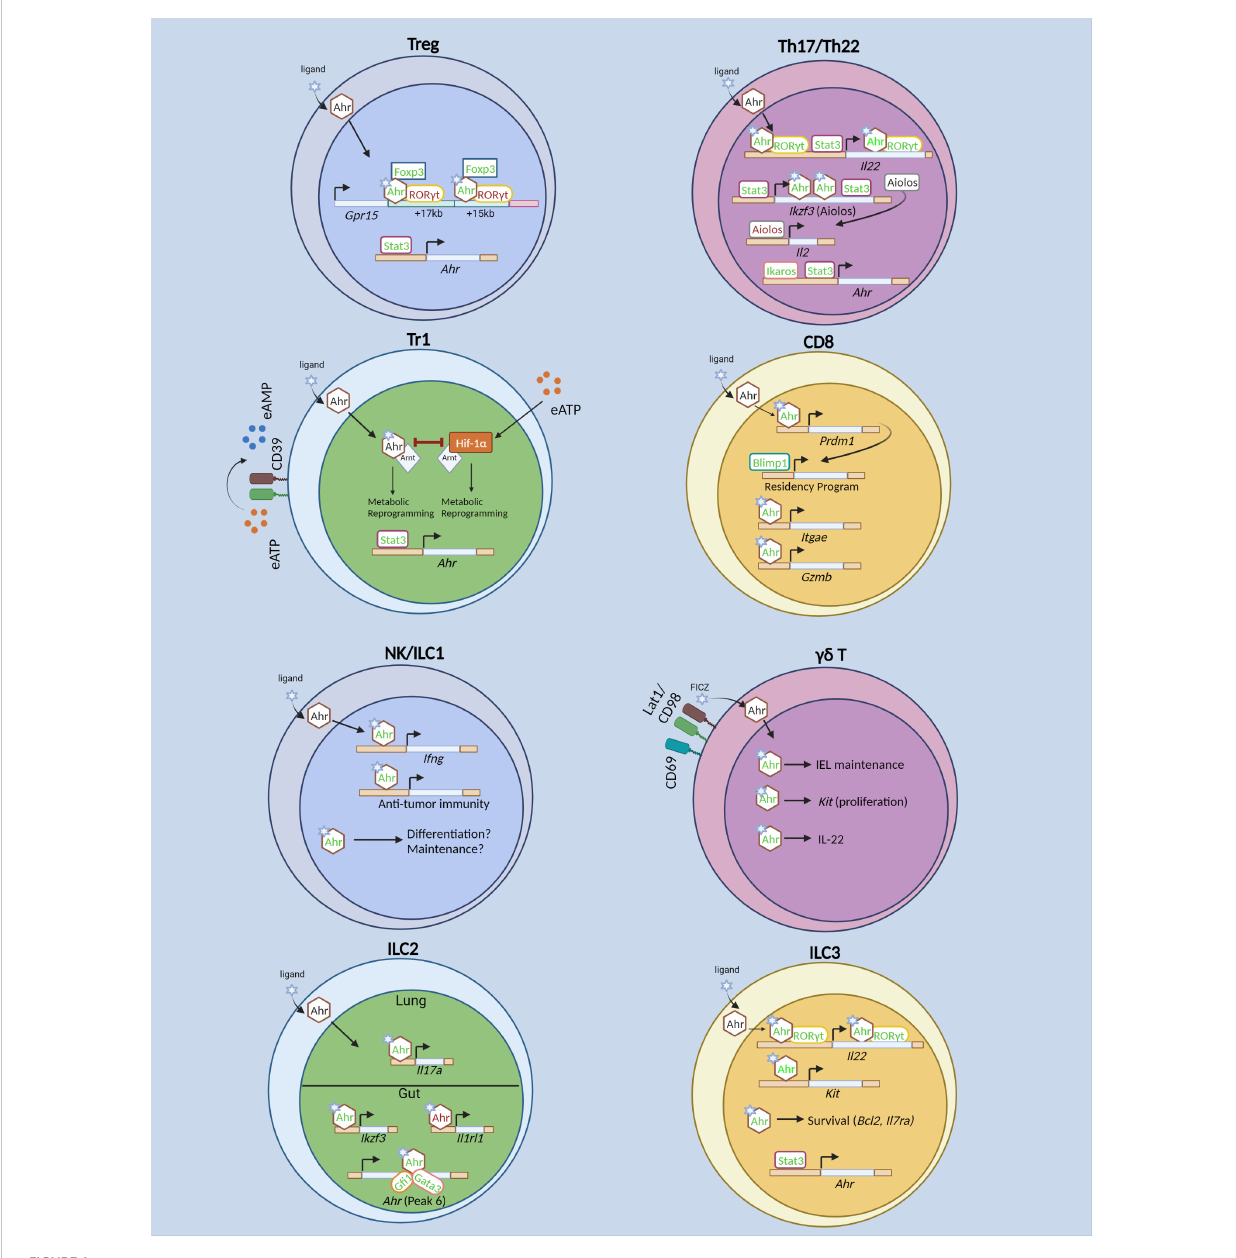
FIGURE 1 Transcriptional regulation of T cells and innate lymphoid cells by the Aryl hydrocarbon receptor (Ahr). In regulatory T (Treg) cells, Stat3 drives Ahr expression. Ahr directly promotes transcription of gut-homing receptor Gpr15. Ahr acts cooperatively with GATA3 and Foxp3 to drive Gpr15 expression. Speci fi cally, Ahr physically interacts with Foxp3 to promote Gpr15 expression. Ahr also interacts with ROR g t, the latter of which acts in opposition to Ahr to restrict Gpr15 expression. In Tr1 cells, Ahr and Hif-1 a promote glycolysis at different timepoints during differentiation. However, Hif-1 a and Ahr antagonize each other as well. Hif-1 a is induced by extracellular ATP (eATP). Stat3 promotes Ahr both by direct binding to the Ahr locus, as well as driving CD39 expression which converts eATP to AMP, thus limiting Hif-1 a -mediated inhibition of Ahr. In Th17 and Th22 cells, Ikaros and Stat3 promote Ahr expression. Ahr cooperates with ROR g t andStat3 todrive Il22 expression. Ahr and Stat3 promote Th17 celldifferentiation by driving expressionof Ikzf3 (Aiolos),which subsequentlylimits IL-2productionand prevents autocrine IL-2signaling. In CD8 + T cells, Ahr is known topromote T RM differentiation in vitro and in vivo . Also, it regulates T RM functionby promoting Gzmb (GranzymeB)expression and enhances polyfunctional CD8 + T cells in tumor models. Ahr expressionis induced in vitro by cytokine stimulation in NKcells and promotes NKcell maintenance. The rolefor Ahr in NKand ILC1 effectorfunction and differentiation areunknown. Ahr promotes gd T cellmaintenancewithin the IEL compartment in partby sustaining Kit expression and promotes IL-22expression. However,it isunclearwhethersimilar mechanisms ofaction ofAhr topromote Kit and Il2 2 transcription as identi fi ed in ILC3s remain intactin gd T cells. In ILC2s, Ahr promotes its own expression in conjunction with Gata3 and G fi 1. Ingut-ILC2s, Ahr restricts ILC2effector function by inhibition of Il1rl1 (encoding ST2). In lung ILC2s, Ahr sustains Il17a (IL-17) production. In ILC3s, Ahr is required for ILC3 proliferation through directregulation of Kit and promotesILC3cellproliferationand survival. In addition, Ahr cooperates with ROR g t todrive Il22 expression. In contrast to Th17 cells, Stat3 does not promote Ahr expression in ILC3s, but may cooperate with Ahr to promote Il22 . Green text indicates transcriptional promotion, while red text indicates transcriptional repression. Created with